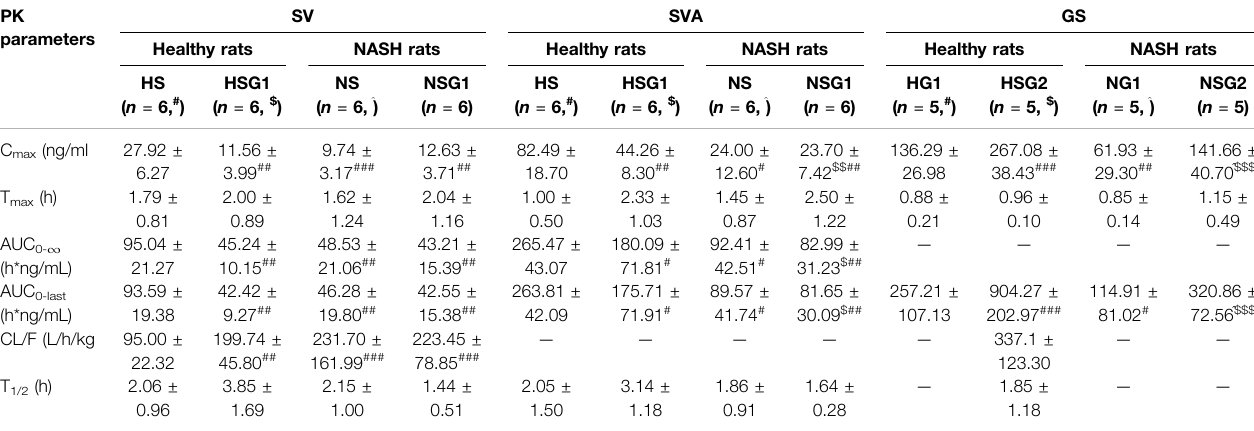
TABLE 2 | Pharmacokinetic (PK) parameters of SV, SVA, and GS in healthy and NASH rats which received SV (8.66 mg/kg, p.o., once daily), GJ (325 mg/kg, p.o., twice daily), and their combination. PK SV SVA GS parameters Healthy rats NASH rats Healthy rats NASH rats Healthy rats NASH